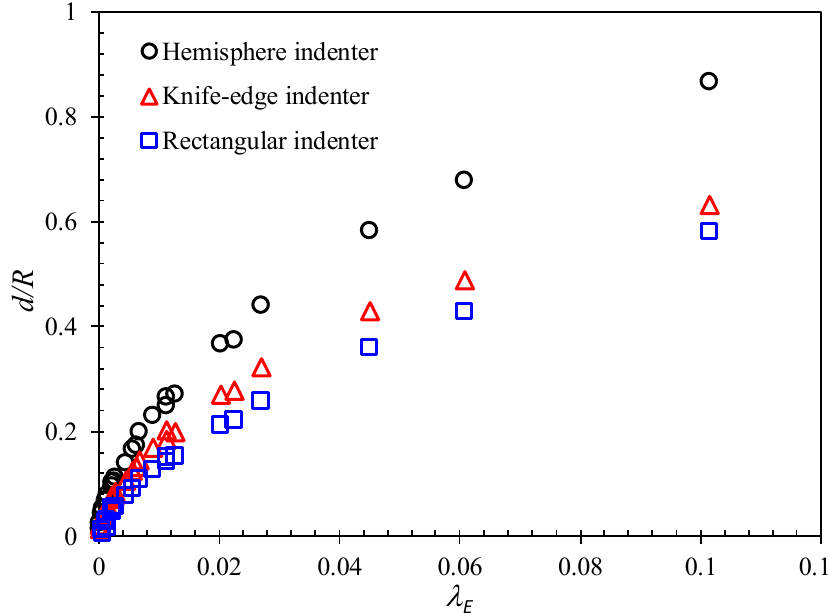
Figure 12. Extent damage of ring-stiffened cylinder for various types of indenter shapes.